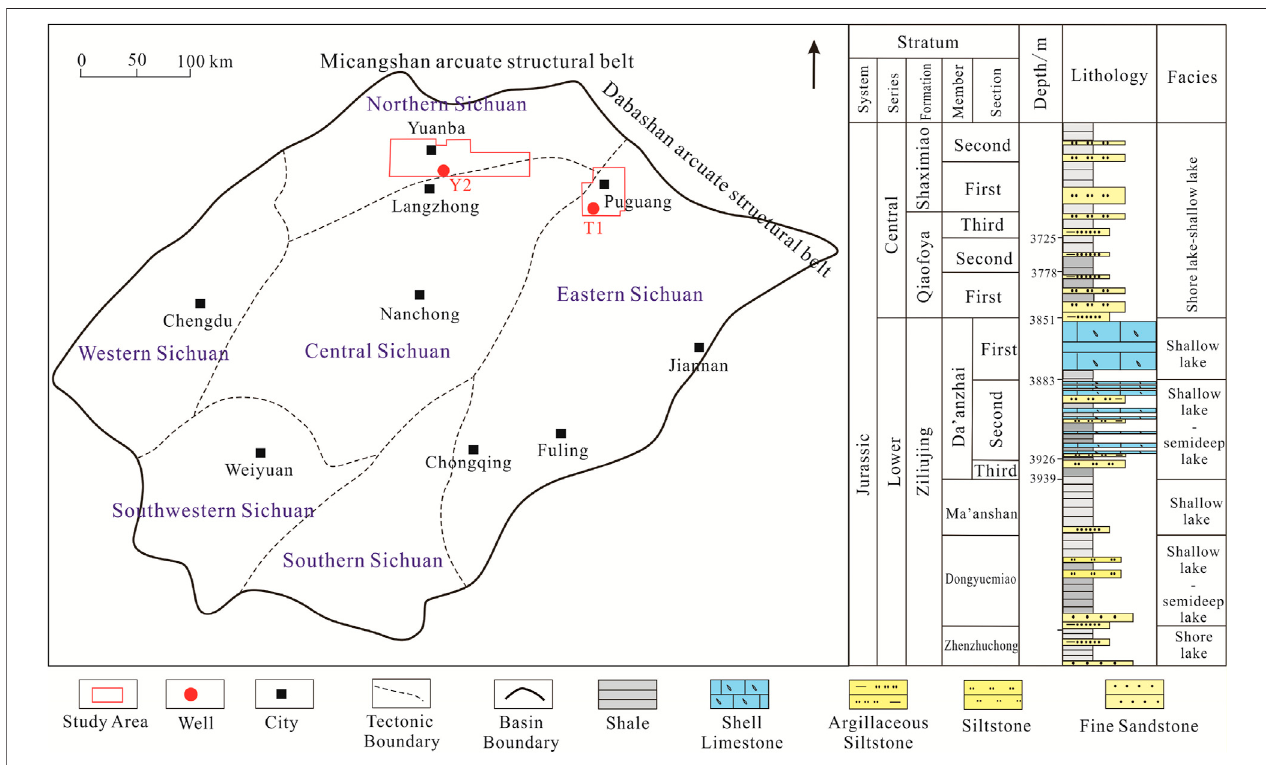
FIGURE 1 | Tectonic location of the study area and stratigraphic histogram of the Jurassic strata.